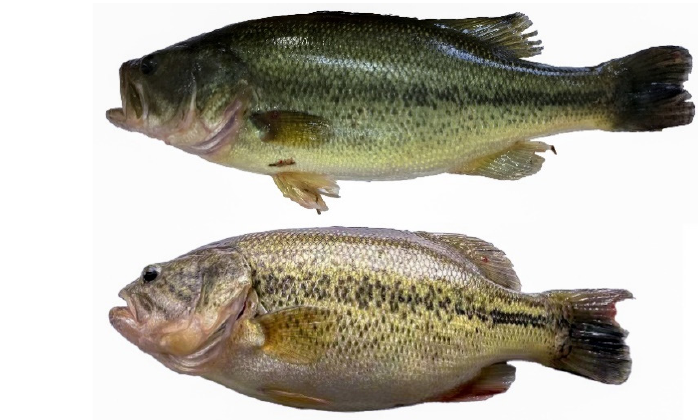
Figure 1. Comparative photographs of Micropterus salmoides in the EM ( A ) and M ( B ) groups. Table 2. Chroma values of largemouth bass skin. Table 1. Growth performance and morphological indices of largemouth bass. Dorsal Skin Abdominal Skin Item